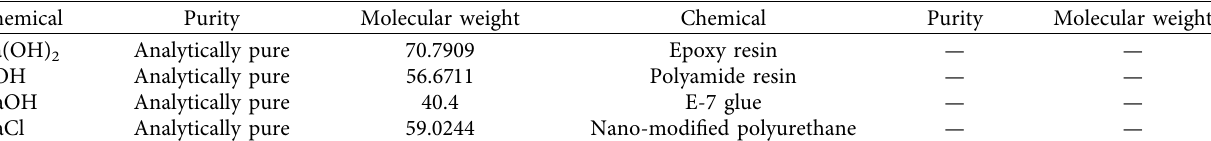
Table 7: Chemical information.